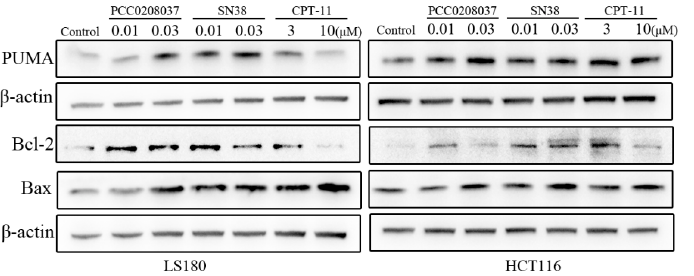
Figure 7. Effects of PCC0208037 on molecules related to cellular apoptosis in CRC cells. Western blotting analysis was conducted to examine the expression of PUMA, Bcl-2, and Bax in HCT116 and LS180 cells treated with PCC0208037 (0.01 and 0.03 µM) for 24 h.